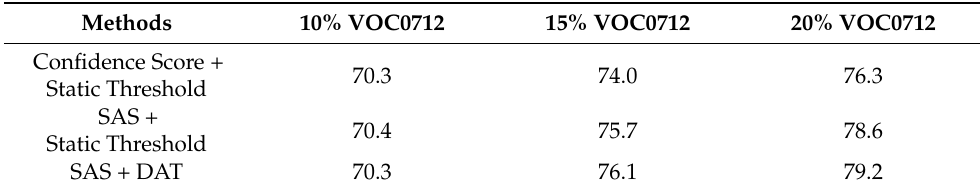
Table 2. Comparison of mAP (%) for different methods.